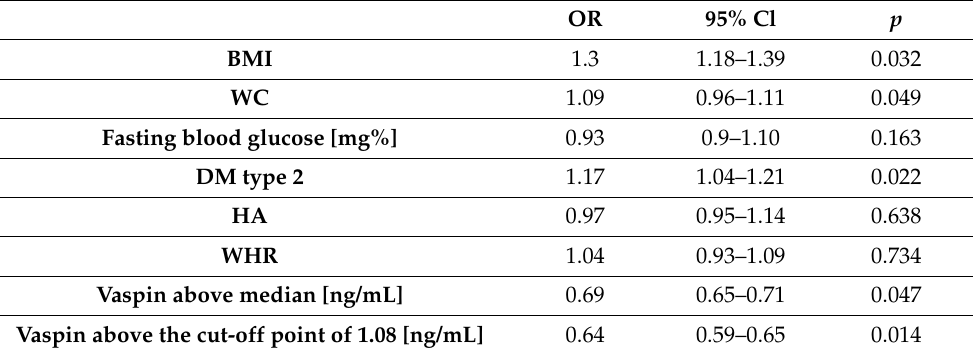
Table 8. Evaluation of vaspin as an independent risk factor for endometrial cancer according to the model of multivariate regression: BMI, body mass index; WC, waist circumference; WHR, waist-hip ratio; HA, arterial hypertension; DM type 2, diabetes mellitus type 2; OR, odds ratio; Cl, confidence interval; p , probability